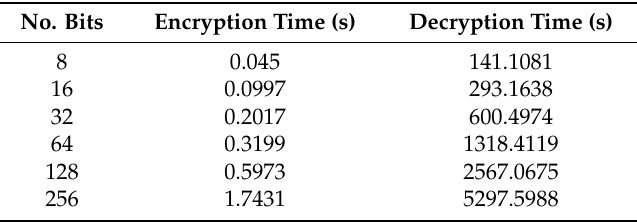
Table 1. Details of the encryption/decryption